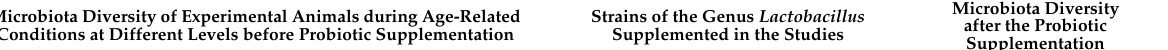
when the host immune system fails to resist the infection with age. Treatment with L. plantarum TWK10 significantly reduced the abundance of Enterobacteriaceae in the aged mice [39]. Table 1. List of different studies indicating the impact of Lactobacillus strains on the restoration of resident gut microbiota in different animal models during ageing. Microbiota Diversity Microbiota Diversity of Experimental Animals during Age-Related Strains of the Genus Lactobacillus after the Probiotic Conditions at Different Levels before Probiotic Supplementation Supplemented in the Studies